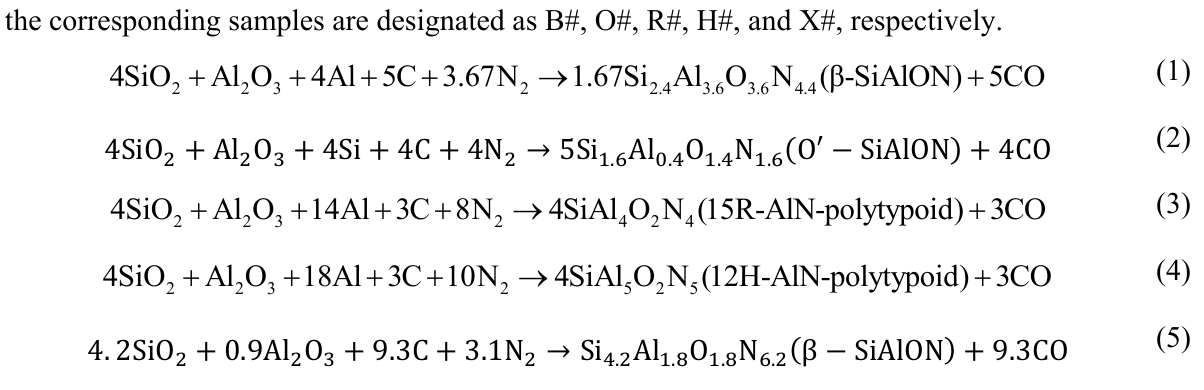
Table 1. Chemical compositions of coal gangue by X-ray fluorescence analysis (wt%). Composition CaO Others